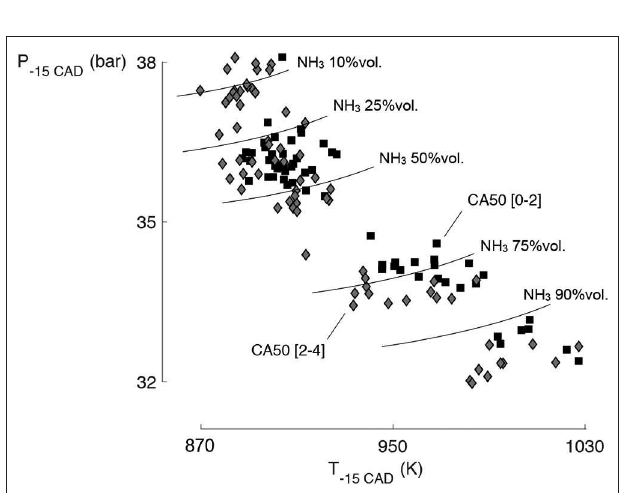
FIGURE 4 | Pressure and temperature region 15 CAD before TDC (all experimental points, CA50 timings between 0 and 4 CAD). The resistance to auto-ignition of ammonia and its high heat capacity value explain why T − 15 is increasing and P − 15 is decreasing with higher ammonia